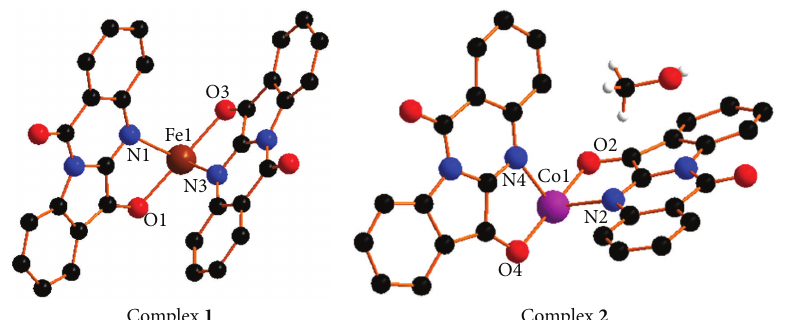
Figure 2: The crystal structures of complexes 1 and 2